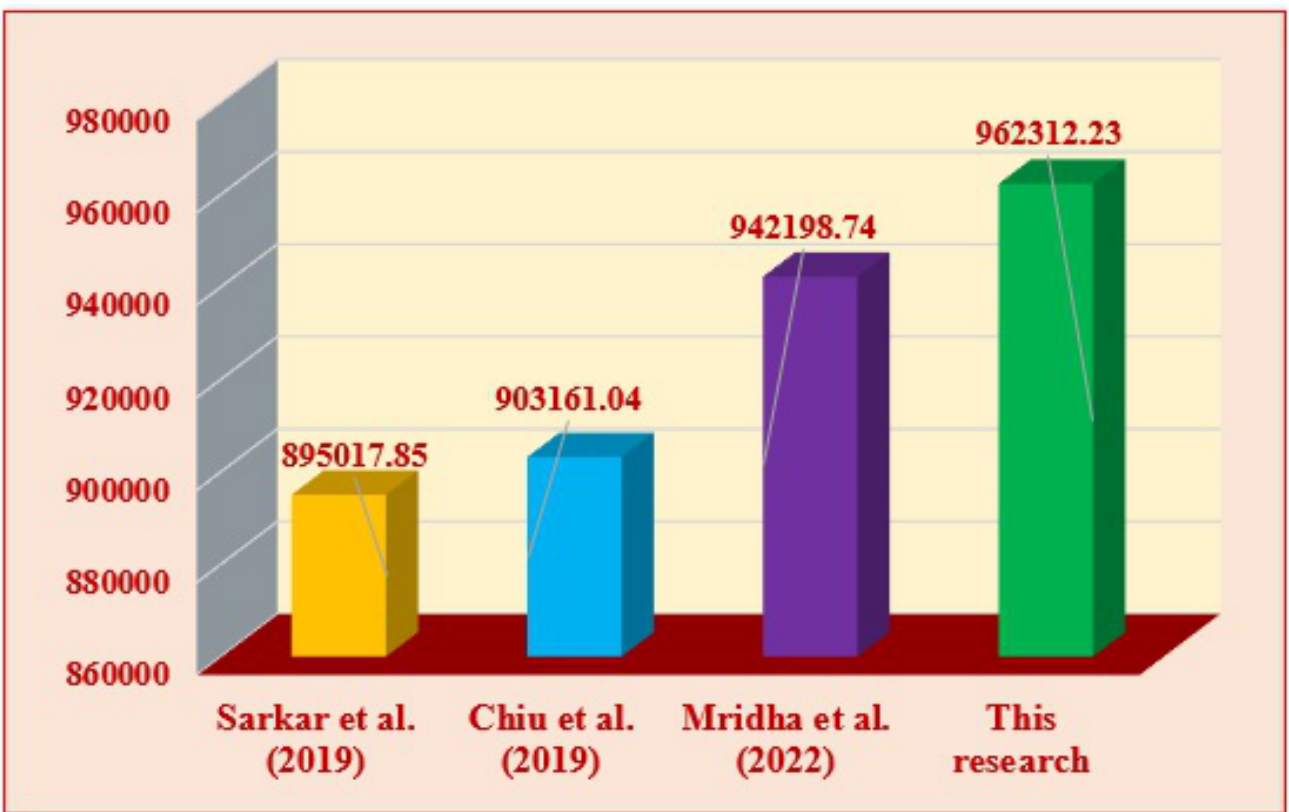
Figure 6. Comparison among the total expected profit of Example 1 and other studies in the litera- ture review